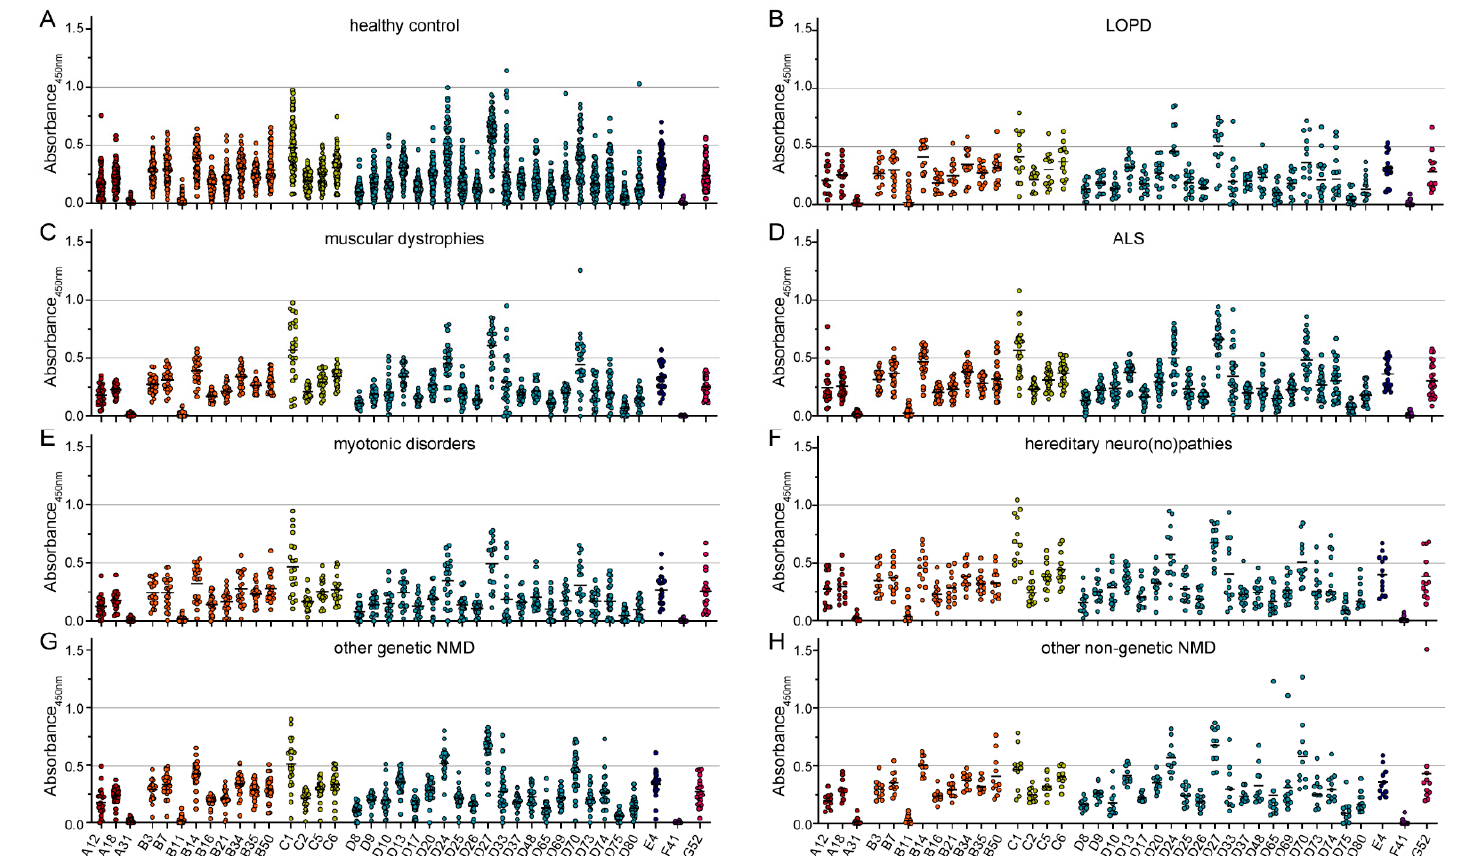
Figure 5. Binding antibody data stratified by health status of serum donors. The data presented in Figure 1 were stratified by the health status of the serum donors, showing data of 76 healthy serum donors ( A ), 14 serum donors with LOPD ( B ), 25 serum donors with muscular dystrophies ( C ), 26 serum donors with ALS ( D ), 20 with myotonic disorders ( E ), 13 with hereditary neuro(no)pathies ( F ), 24 with other genetic NMD ( G ) and 11 serum donors with non-genetic NMD ( H ). Each dot represents an individual sample, lines indicate mean values of all sera for the indicated HAdV type. No statistically significant differences in binding antibody levels of the different NMD groups compared to the healthy control group were found using Kruskal-Wallis one-way ANOVA on ranks and Dunn’s multiple comparisons test.